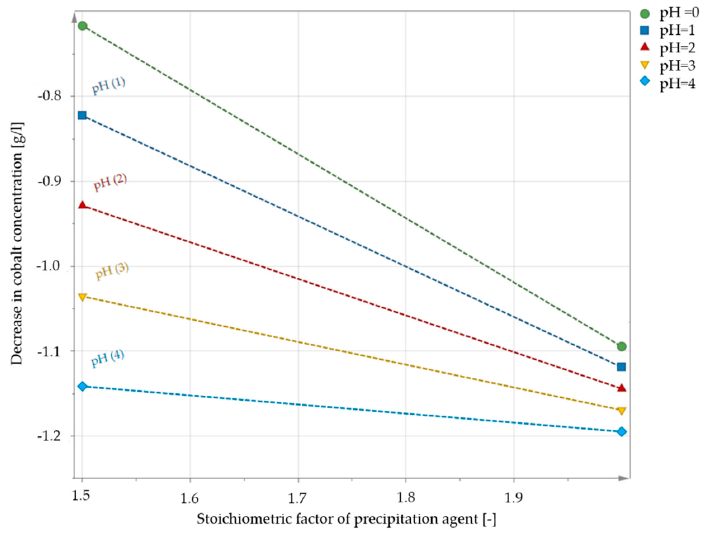
Figure 10. Influence of the pH on the di ff erence of cobalt concentration between the stoichiometric addition of 1.5 and